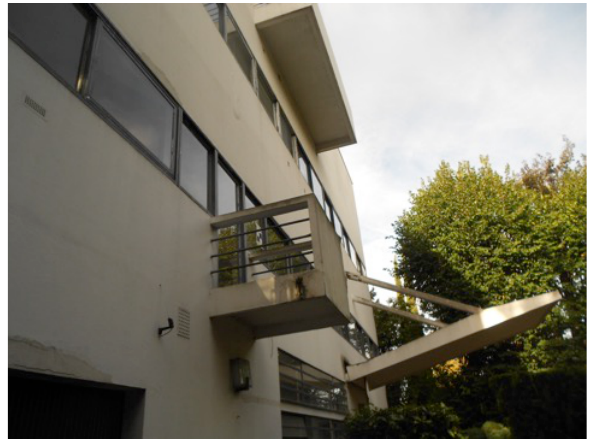
Figure 4. Detail of the Northern façade, current state [Di Resta, 2015]